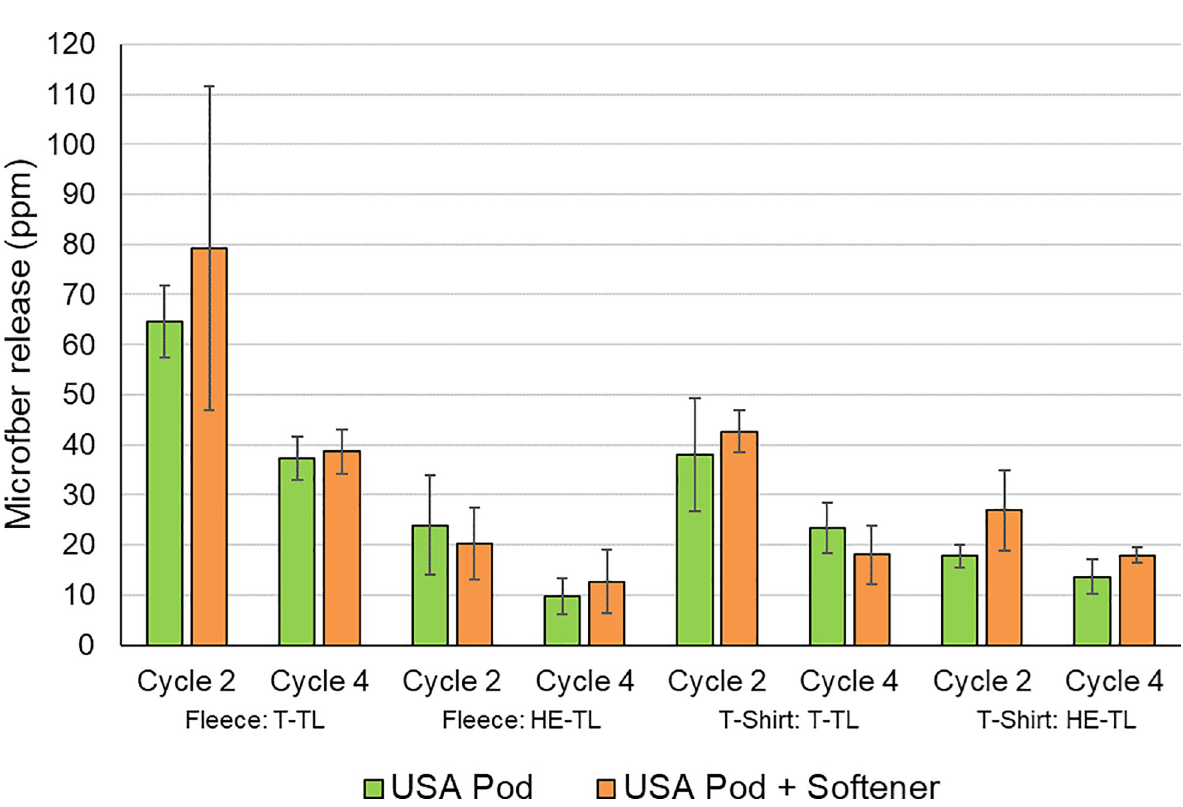
Fig 8. Impact of fabric softener on microfiber release from polyester fleece and performance T-shirt (n = 64). U.S.A. Traditional Top Loader (T-TL) and High-Efficiency Top-Loader (HE-TL) conditions. Error bars represent the standard deviation.